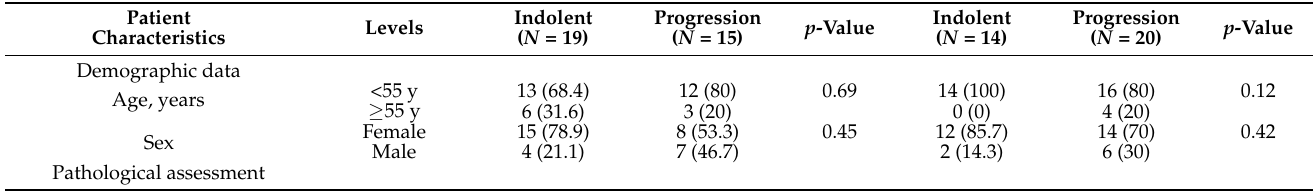
Table 2. Comparison between thyroid cancer patients according to their progression, stratified by radioactive iodine